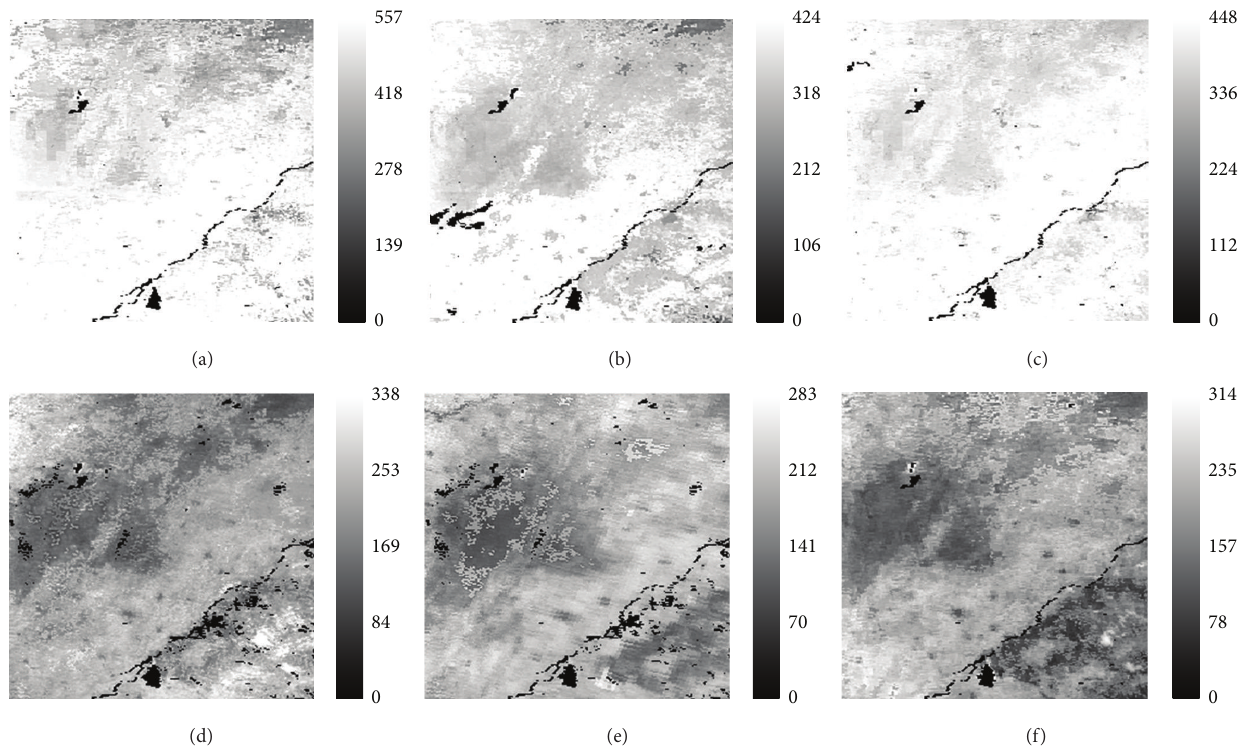
Figure 7: The assimilated EPs from the AWT-PEKF method at 15:00 solar time. (a) The assimilated EP on May 2, 2005; (b) the assimilated EP on May 7, 2005; (c) the assimilated EP on May 14, 2005; (d) the assimilated EP on May 19, 2005; (e) the assimilated EP on May 25, 2005; (f) the assimilated EP on May 31, 2005.